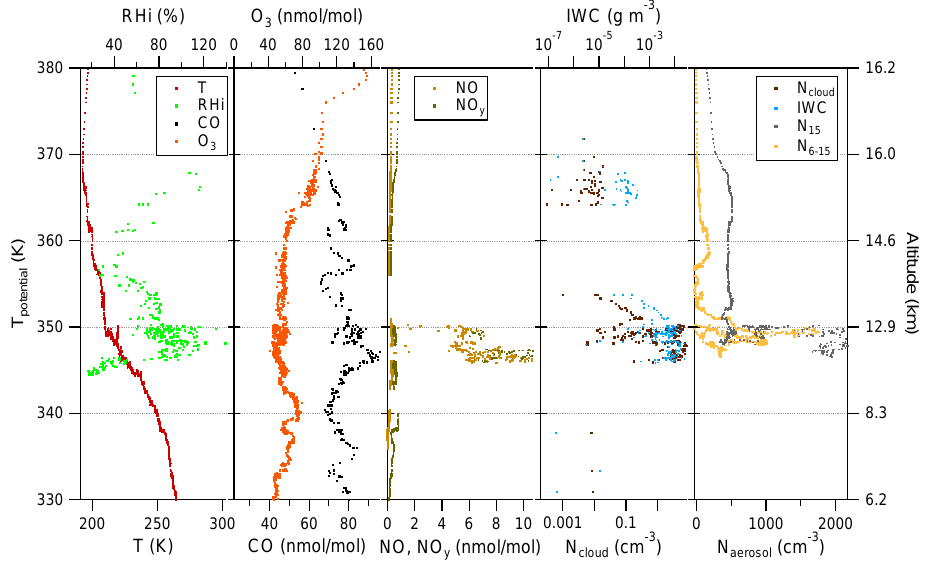
Fig. 3. Vertical profiles recorded by the instruments aboard M-55 Geophysica during its descent into Ouagadougou, Burkina Faso, on 7 August 2006.